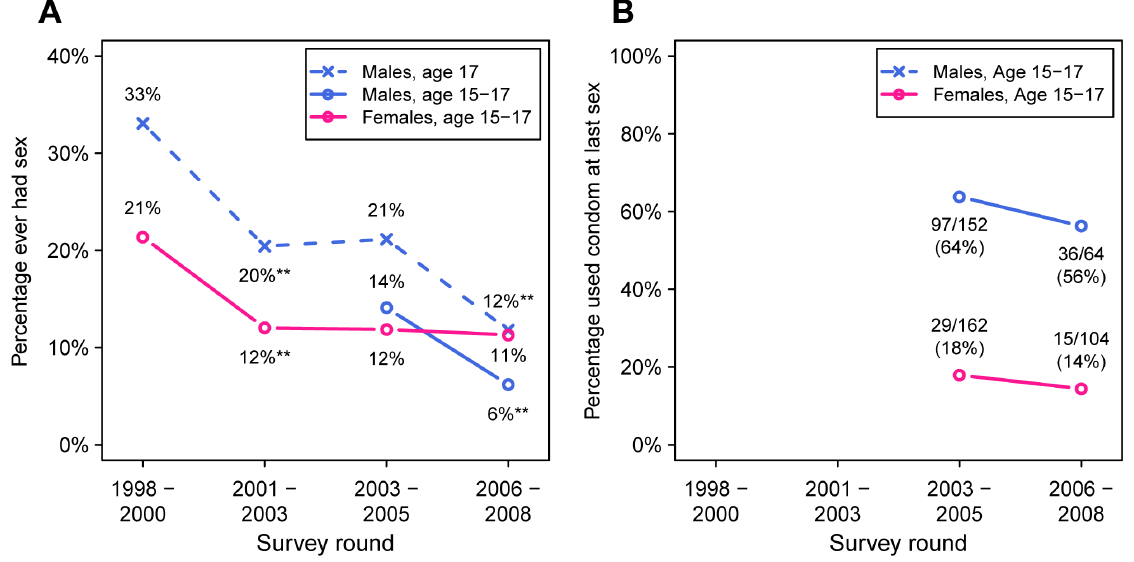
Figure 2. Trends in reported sexual behaviour amongst adolescents age 15 to 17 years. Panel A shows the percentage of adolescents in each cohort who report ever having had sex. Panel B indicates the percentage of respondents who reported using a condom at their last sex, amongst those who have ever had sex. Asterisks denote a statistically significant decline between cohorts (two-sided Fisher’s exact test, all significant at level P , 0.001). Because males were only enroled from the age of 17 in the first two survey rounds, the dashed blued line shows the trend in the proportion of sexually experienced 17 year-old males, and the solid blue line shows the trend for 15 to 17 year-old males in the two most recent rounds. doi:10.1371/journal.pone.0070447.g002 PLOS ONE |